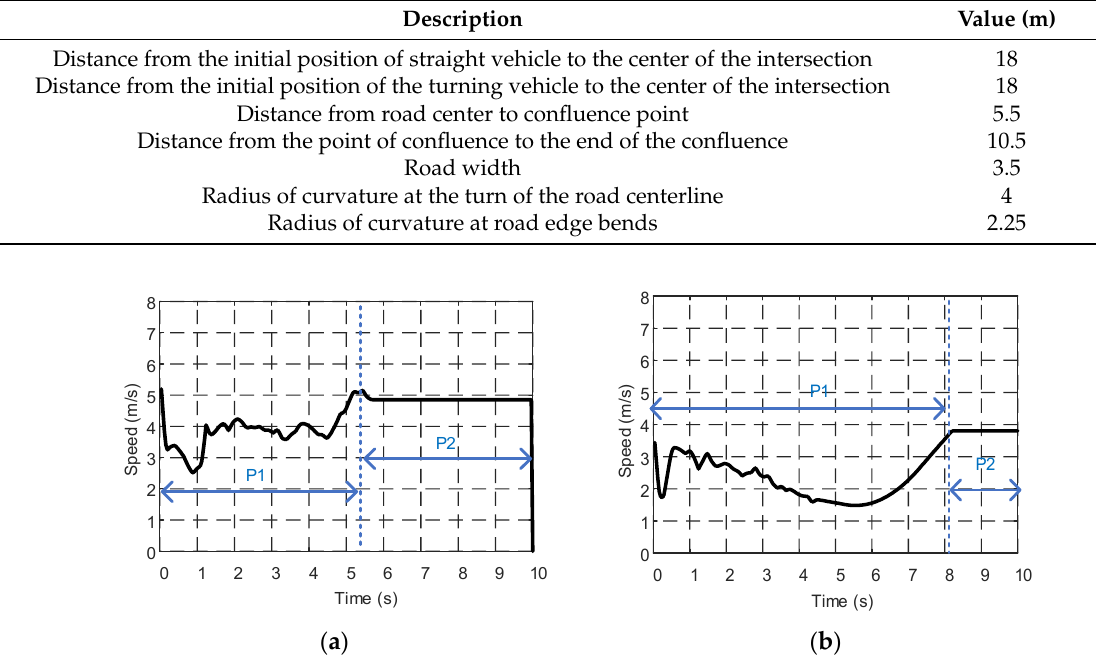
Figure 15. Speed curve of turning vehicle in cosimulation: ( a ) condition I and ( b ) condition II. Table 3. Related parameters in RL.